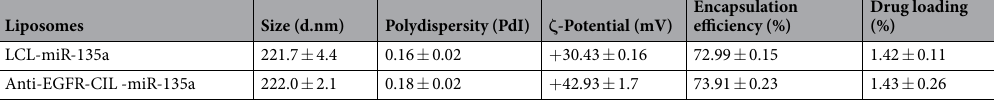
Table 2. C Characterization of the liposomes by size and ζ -Potential. ζ -potential, PDI, particle size,